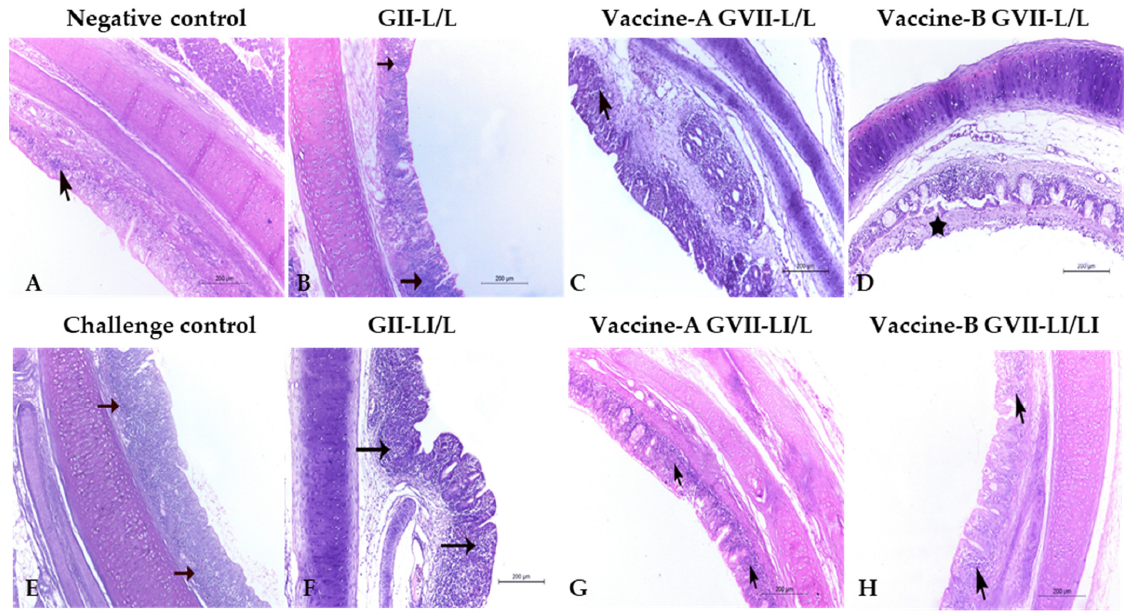
Figure 2. Trachea in vaccinated and control groups chicks at 3 days post challenge (H & E stain, ×100), showing the negative control normal histopathological architecture of the trachea ( A ). The challenge control ( E ). All vaccinated group’s ( D , H ) tracheal structures were as in the normal group except for the LaSota GII LI\L ( B , F ) and the vaccine-B GVII L/L ( C , G ) groups. Abbreviations: GII: genotype II-based vaccine, GVII: genotype VII.1.1.-based vaccine, L/L: live vaccine at 7 and 21 days, LI/L: live and inactivated at 7 days, then live vaccine at 21 days.